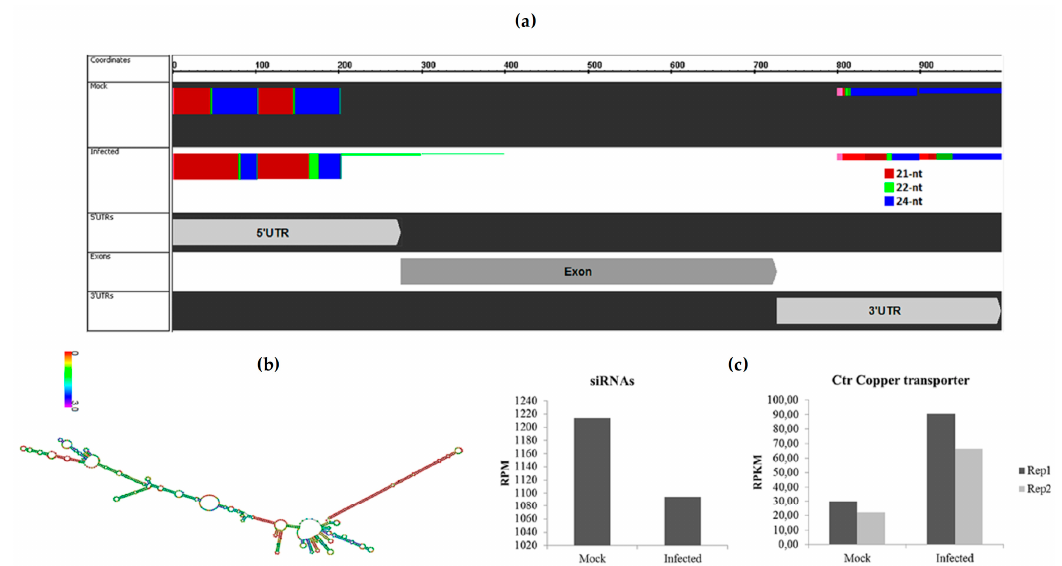
Figure 4. siRNAs regulate copper transporter. ( a ) Alignment of a cluster of siRNAs from sRNA libraries in Ctr copper transporter. Colors represent sRNAs with different lengths. ( b ) Structure of the Ctr copper transporter transcript. The long hairpin in red is the 5 ′ UTR region. ( c ) Expression levels of siRNA cluster that aligned with Ctr copper transporter from sRNA libraries, and the expression of Ctr copper transporter using data from the transcriptome of sugarcane infected with A. avenae and mock-inoculated. Two biological replicates of these transcriptomes were used [30]. RPM: Reads Per Million; RPKM: Reads Per Kilobase Million.